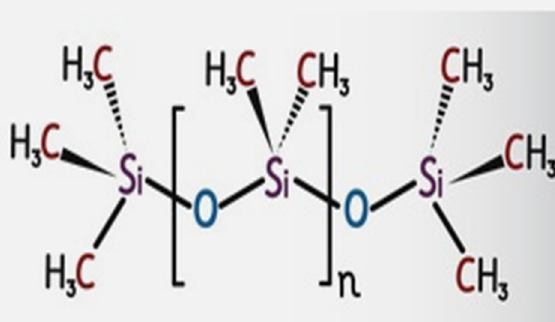
Figure 1. The chemical structure of silicone rubber.